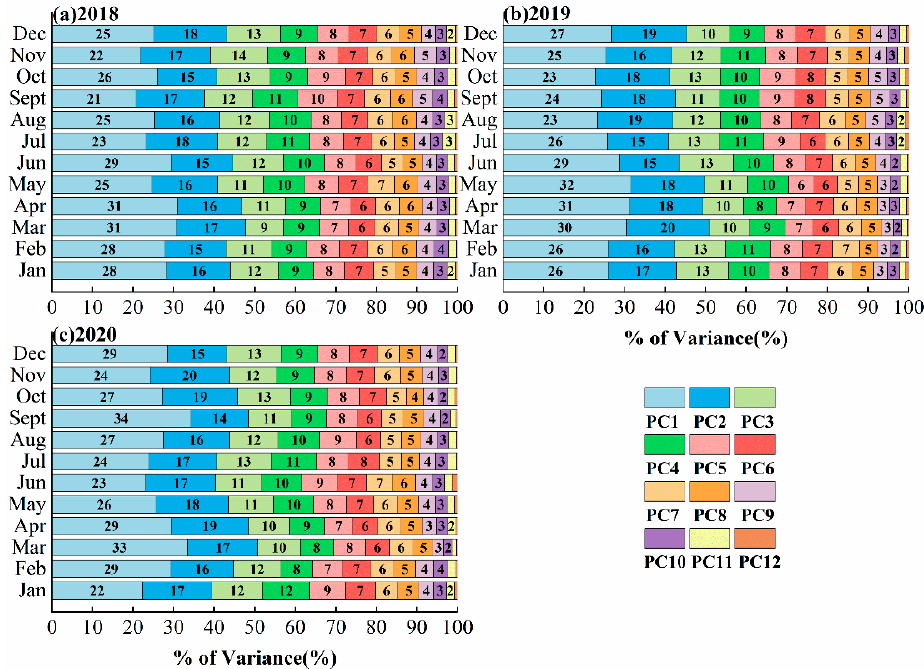
Figure 6. Results of PCA for each month of ( a ) 2018, ( b ) 2019, and ( c ) 2020. The short bars of different colors inside each long bar in the figure indicate the % of variance of different principal components; the number inside each short bar indicates the % of variance of the corresponding principal component (when the percentage of variance is less than 2%, the annotation will be ignored); the long bar formed by superimposing each short bar indicates the cumulative % of variance of the principal component in the corresponding month.